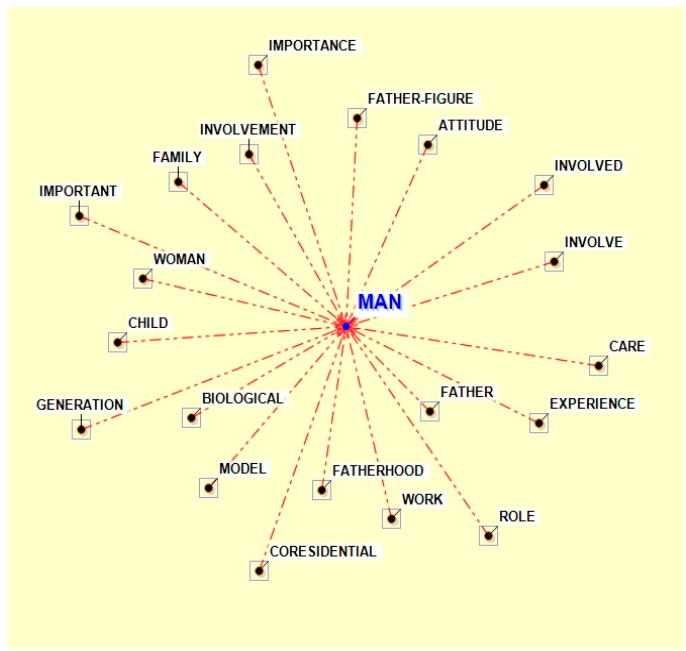
Figure 11. Radial diagram with Man.